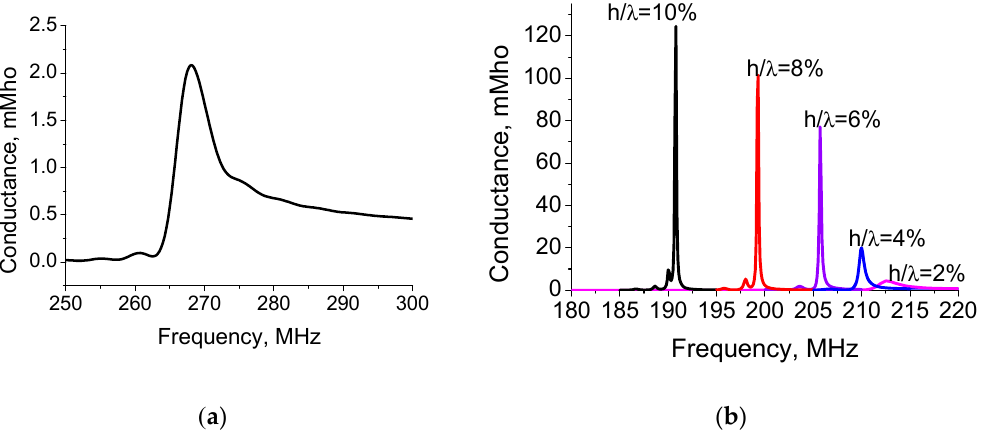
Figure 8. ( a ) Bleustein–Gulyaev wave IDT conductance response versus frequency for uniform IDT with 100 Ti electrodes with period λ = 16 μ m and electrode thickness 60 nm; ( b ) for the uniform IDT with 100 Ti electrodes with period λ = 16 µ m and electrode thickness 60 nm; ( b ) for the uniform IDT with 100 Al electrodes with period λ = 20 μ m and different thicknesses on the Y-cut of KTP and the with 100 Al electrodes with period λ = 20 µ m and different thicknesses on the Y-cut of KTP and the wave propagation direction along the crystal X-axis. wave propagation direction along the crystal